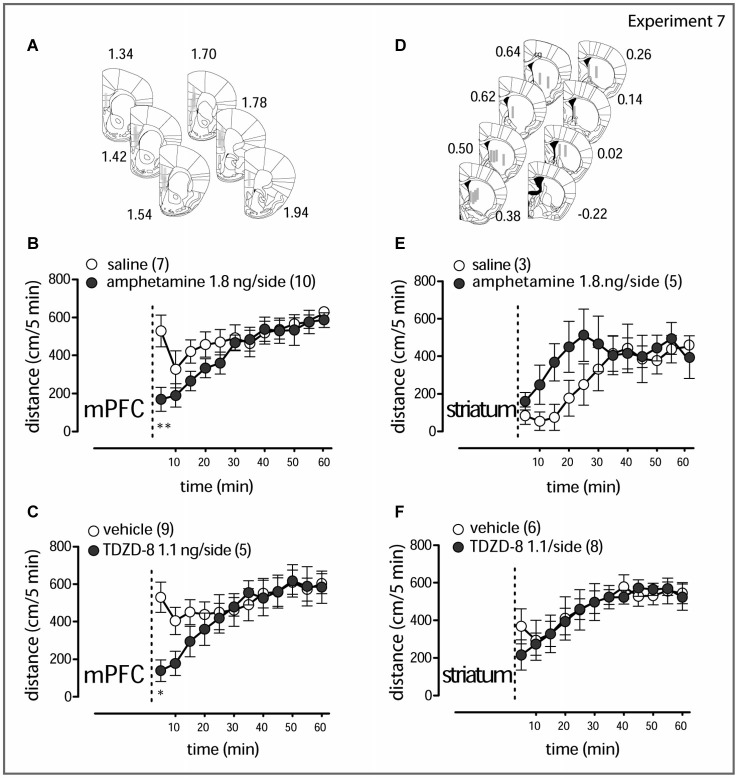
Local amphetamine and TDZD-8 treatment (A,D). Schematic representation of the drug infusion loci. The rectangles correspond to tracks of the injection cannula tip (1 mm) in the mPFC and the striatum. Results for right and left hemisphere examinations are pooled together. The computer-based atlas by Paxinos and Franklin (2001) was used to mark probe locations; numbers refer to distances from the bregma, mm. Amphetamine (1.8 ng/side, B) and TDZD-8 (1.1 ng/side, C) transiently counteract the hyperlocomotor activity in LAB mice when injected in the mPFC. Amphetamine (1.8 ng/side, E) rather stimulates locomotion, when injected in the striatum, whereas TDZD-8 (1.1 ng/side, F) does not exert any action. The dashed lines mark the moment of drug administration (2–3 min before the animal is placed into the OF test box). Open circles correspond to saline/vehicle treatment; filled circles correspond to drug treatment. *p < 0.05, **p < 0.01.